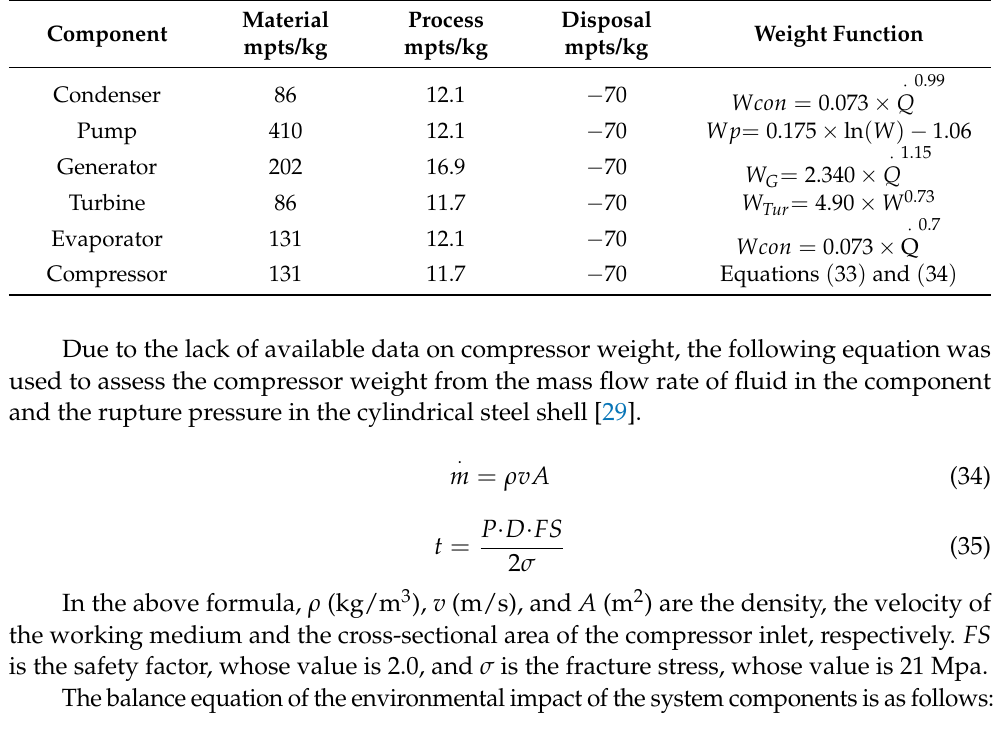
Table 4. Environmental impact data related to equipment in life cycle